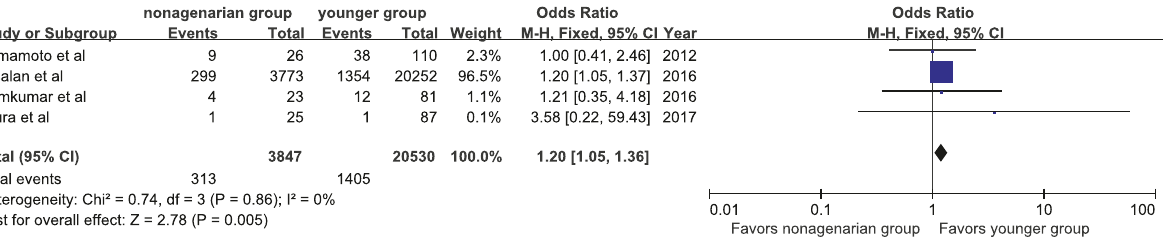
Figure 6: Forest plot of pooled analysis comparing the rates of major or life-threatening bleeding in nonagenarians versus younger patients.